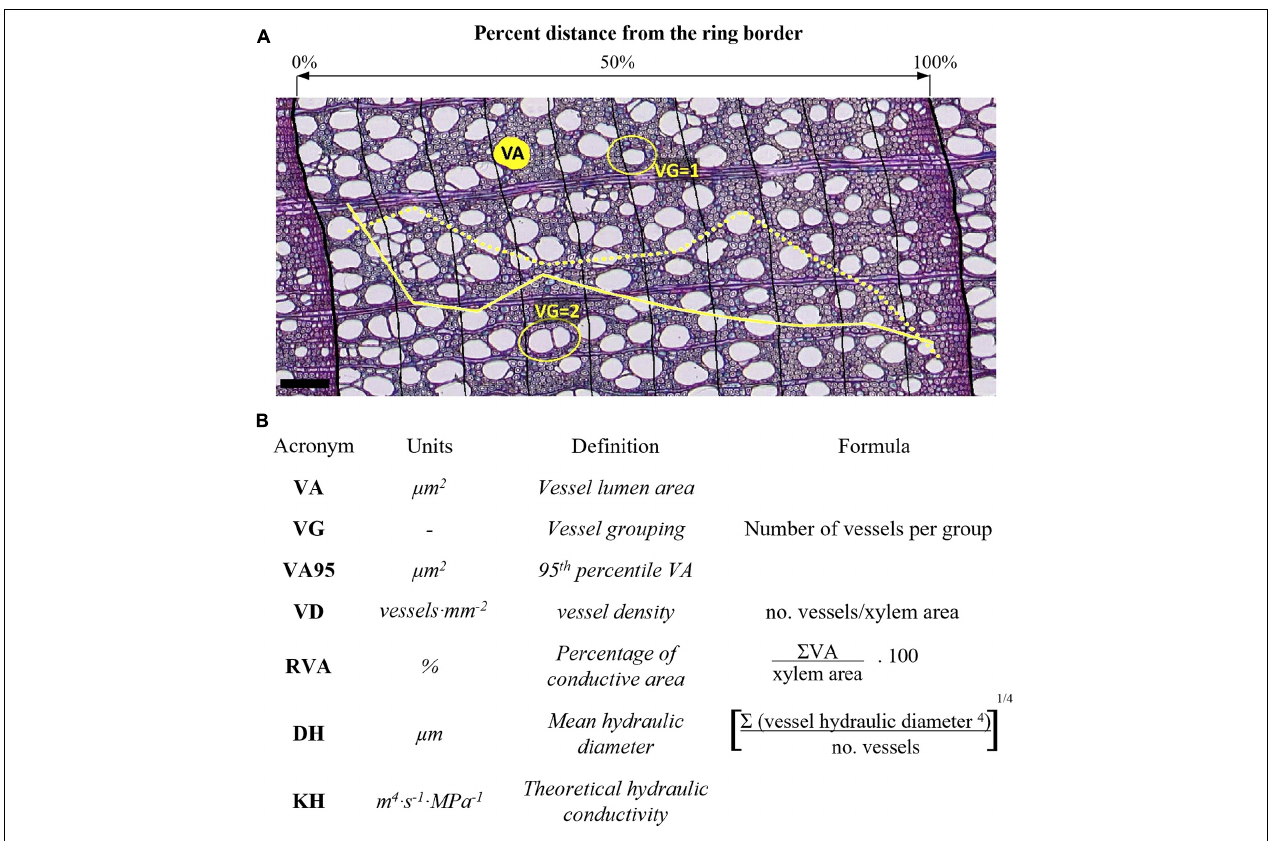
FIGURE 2 | Illustration of (A) anatomical measurements and (B) anatomical traits with acronyms and formulas. Thick black lines in (A) denote ring borders and thin lines denote intra-ring sector limits. The solid yellow curve in (A) shows the relative intra-ring changes in vessel grouping (VG), the dotted yellow curve shows the relative intra-ring changes in mean vessel area (VA). Scale bar = 100 µ